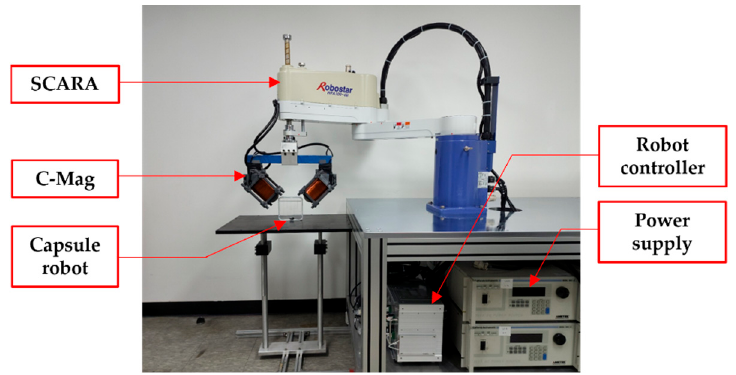
Figure 9. Constructed C-mag and experimental setup.